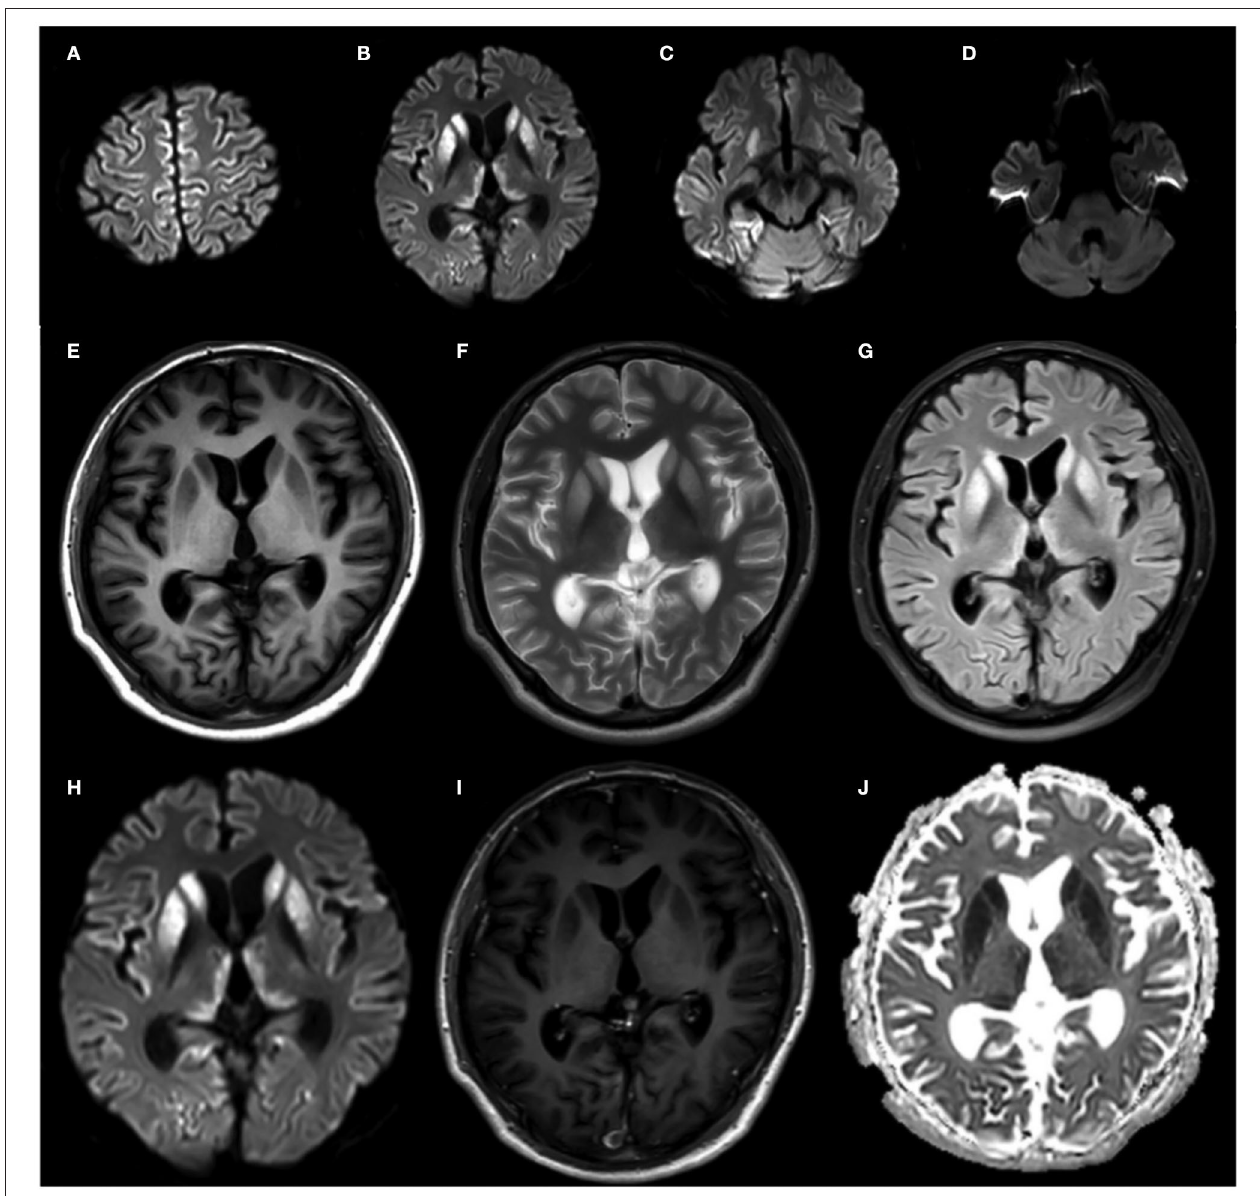
FIGURE 3 | Brain MRI of the proband at 20 months after onset. (A–D) DWI sequences displayed restricted diffusion in the bilateral frontal and parietal cortex. (E–J) Bilateral basal ganglia hyperintensities, with slight bilateral pulvinar and dorsomedial thalamus hyperintensities on FLAIR (I) and DWI (J) sequences. 1-OPRD of the PrP in the patient was identified ( Figure 5